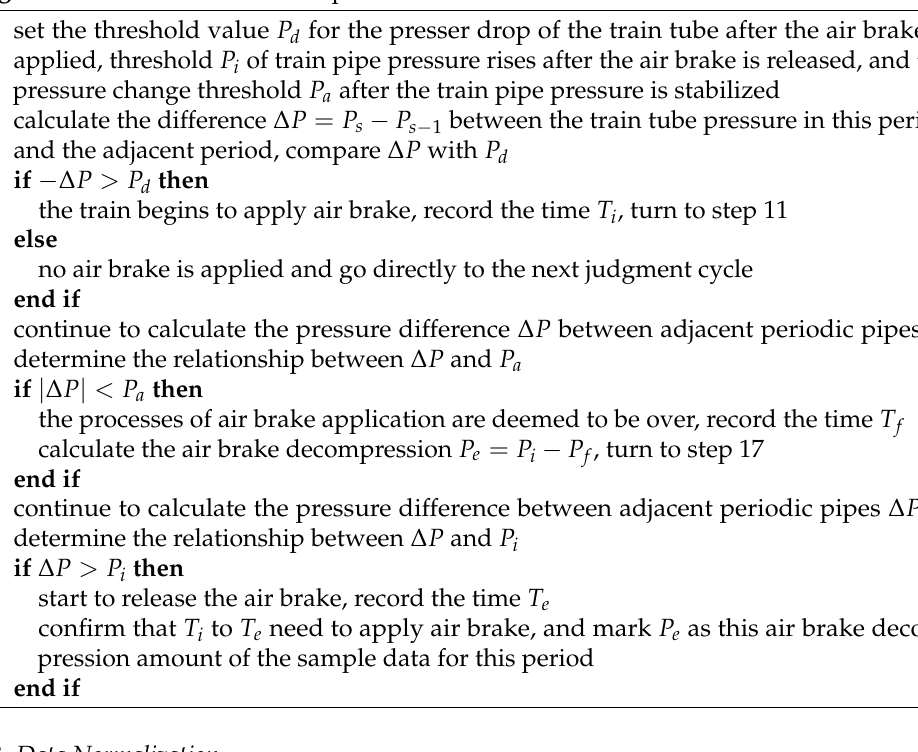
Algorithm 1 An air brake decompression calculation